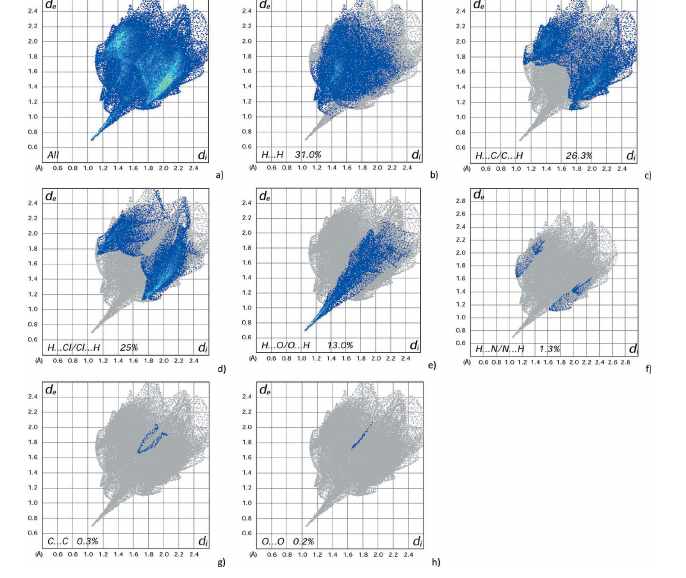
Figure 4 Full two-dimensional fingerprint plots for the title compound, showing all interactions ( a ), and delineated into ( b ) H (cid:2)(cid:2)(cid:2) H, ( c ) H (cid:2)(cid:2)(cid:2) C/C (cid:2)(cid:2)(cid:2) H, ( d ) H (cid:2)(cid:2)(cid:2) Cl/Cl (cid:2)(cid:2)(cid:2) H, ( e ) H (cid:2)(cid:2)(cid:2) O/O (cid:2)(cid:2)(cid:2) H, ( f ) H (cid:2)(cid:2)(cid:2) N/N (cid:2)(cid:2)(cid:2) H, ( g ) C (cid:2)(cid:2)(cid:2) C and ( h ) O (cid:2)(cid:2)(cid:2) O interactions. The d i and d e values are the closest internal and external distances (in A˚ ) from a given point on the Hirshfeld surface depicted in Fig. 3.